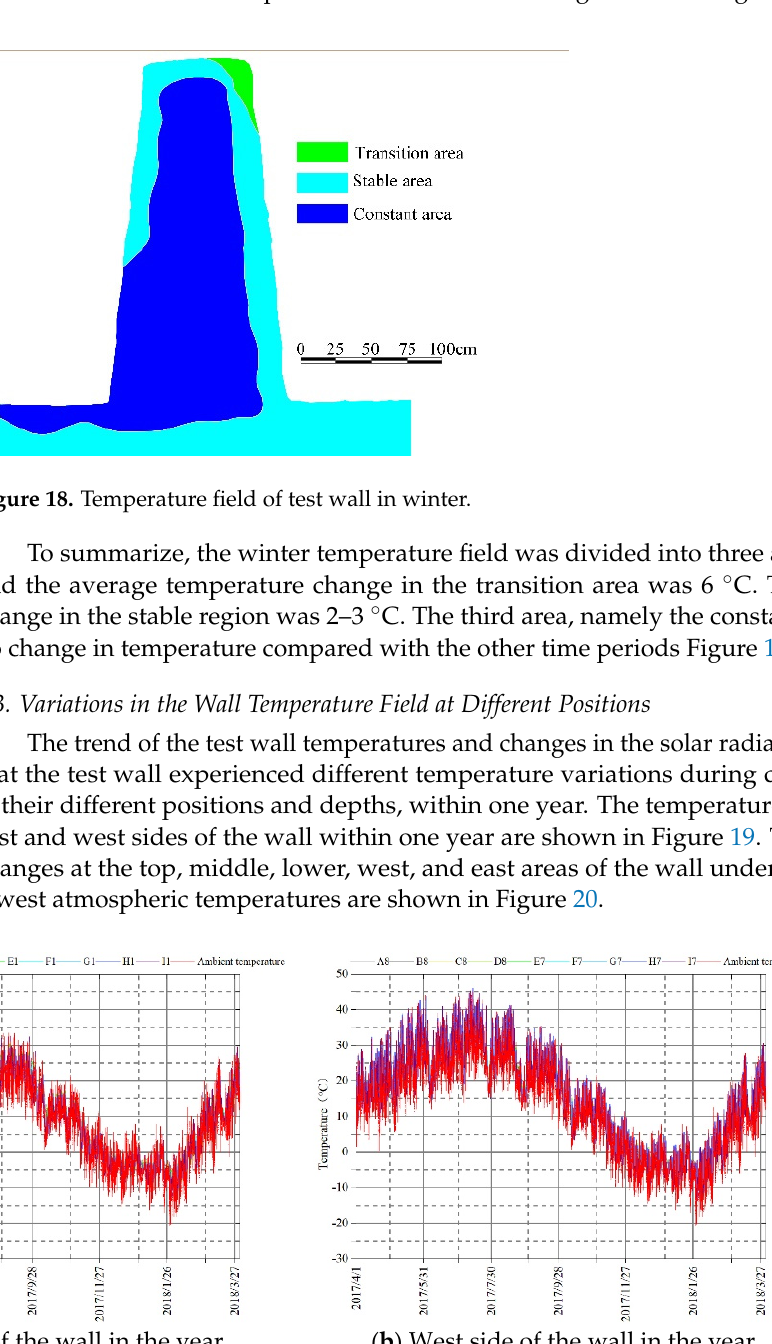
Figure 19. Temperature change characteristic on the wall in the year (1 April 2017–31 March 2018).